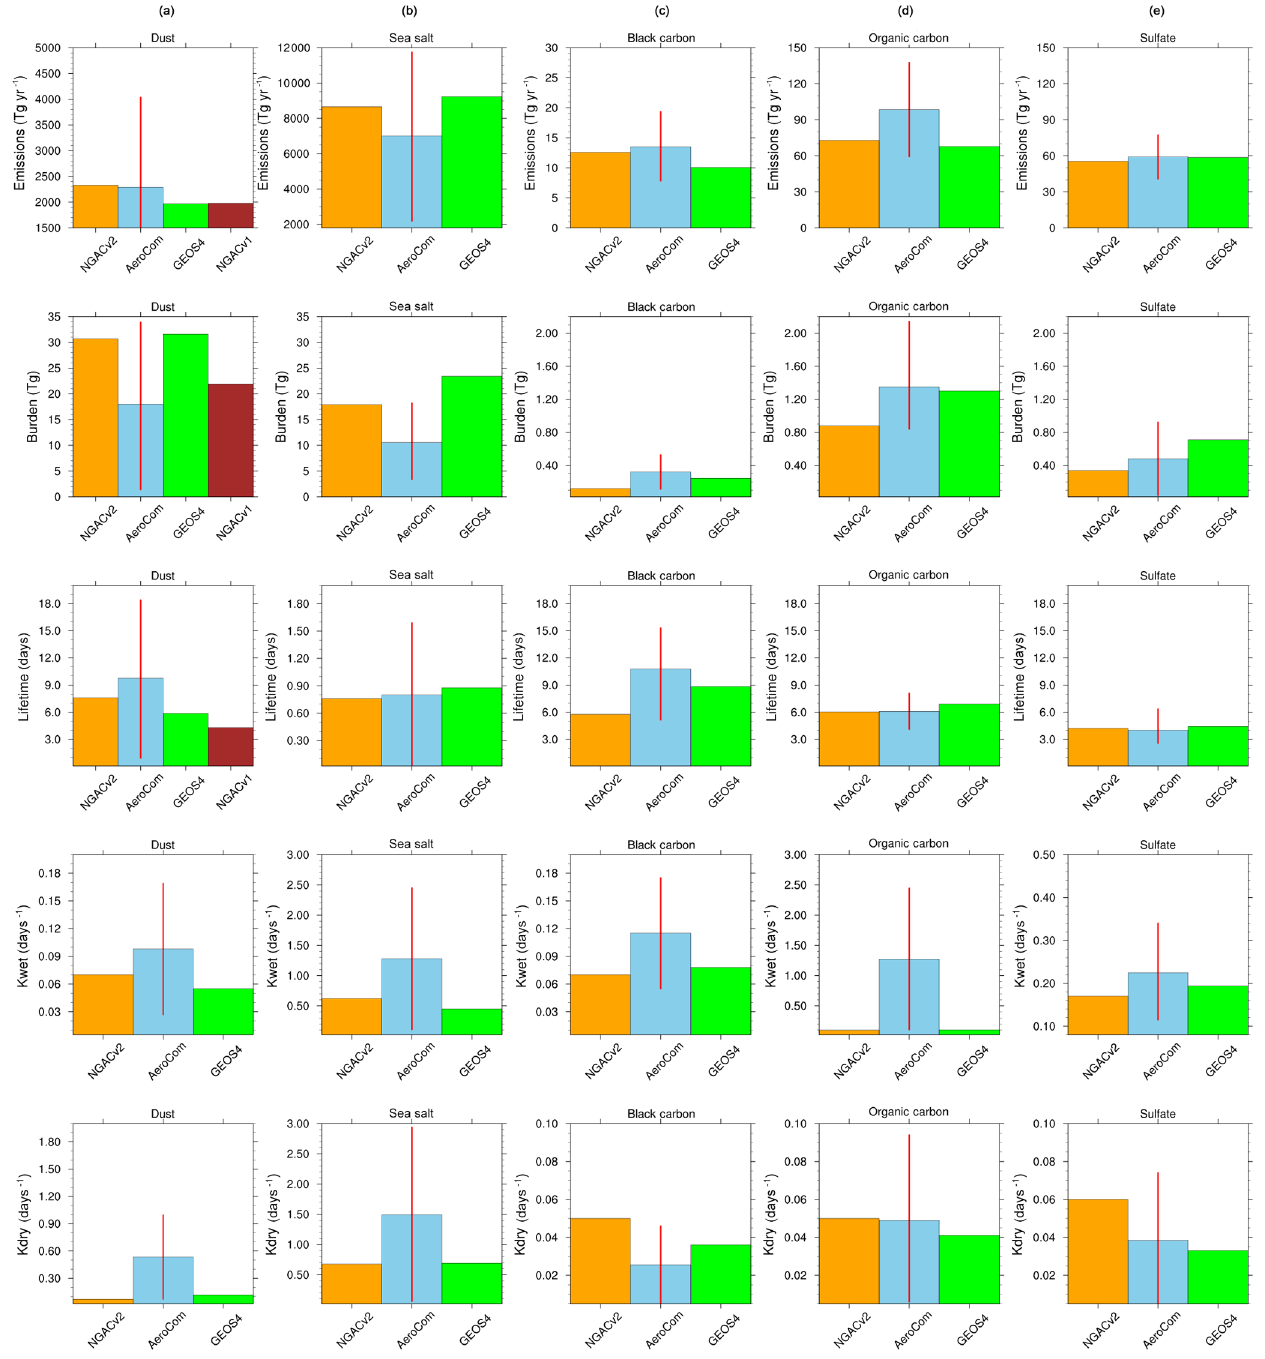
Figure 2. Global annual total aerosol emissions and annual average aerosol burdens, lifetimes, and loss frequencies in NGACv2, AeroCom models, GOES4, and NGACv1 (dust-only). For AeroCom models, the red vertical lines show the maximal and minimal values, and the bar shows the mean value. Column (a) is for dust, column (b) is for sea salt aerosols, column (c) is for black carbon, column (d) is for organic carbon, and column (e) is for sulfate. Sulfate is for sulfur amount only (Colarco et al.,